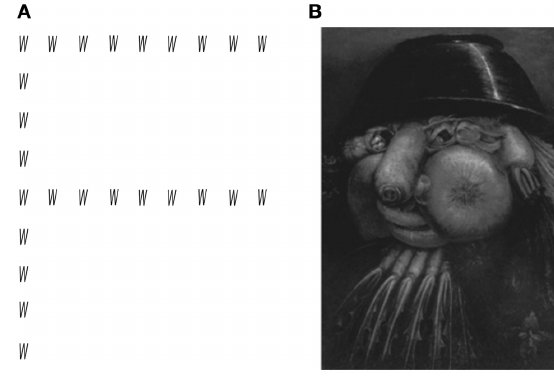
FIGURE 1 | Examples of hierarchical stimuli frequently used as stimuli in experiments with patients with Bálint syndrome, (A) global letter made up of local letters; (B) global face made up of a theme of local elements, in this case fruit. Painting by Giuseppe